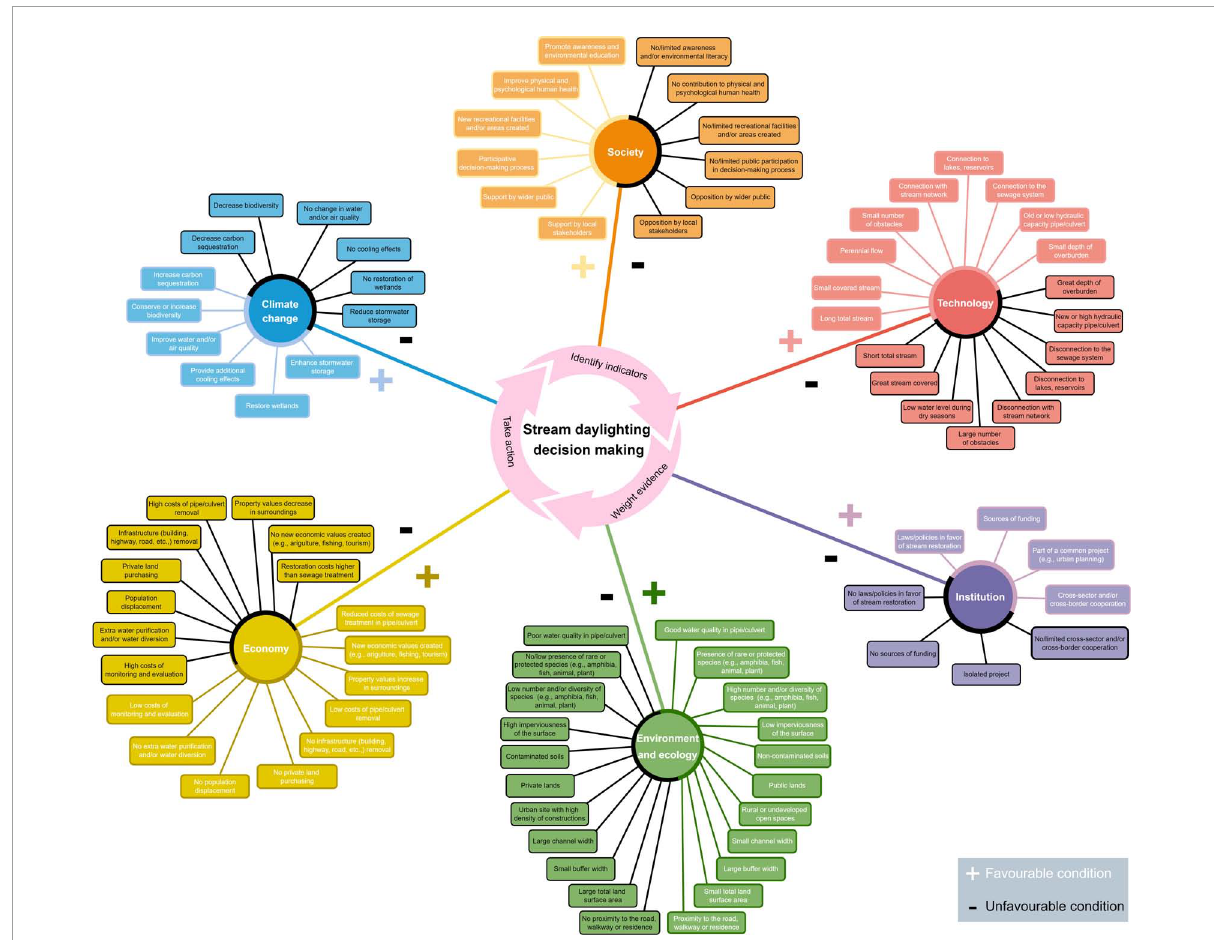
FIGURE18 Elements for a preliminary decision support framework for the choice of stream daylighting candidates.